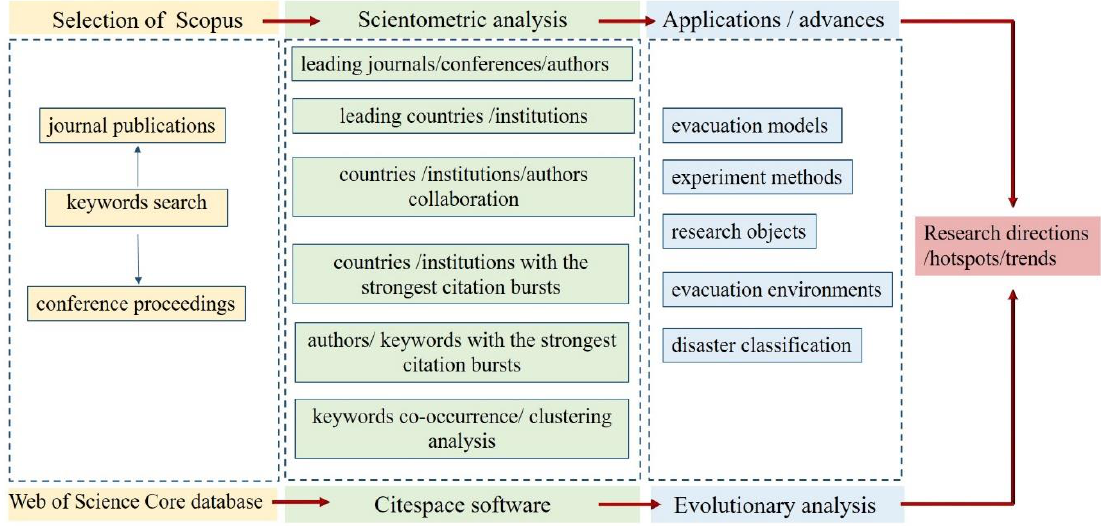
Figure 1. Research route on fire safety evacuation in buildings.